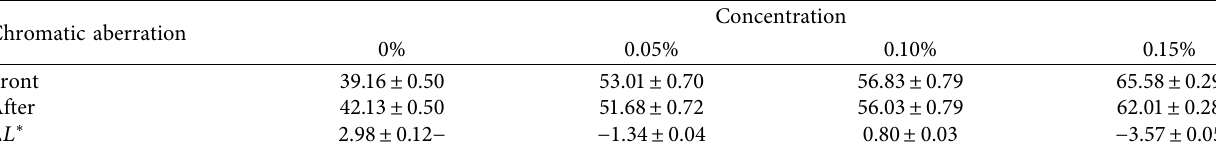
Table 1: L ∗ value and differences before and after the aging of silicon aluminum-coated nano-TiO with different concentrations ( F � 7486.332, P < 0 . 05).